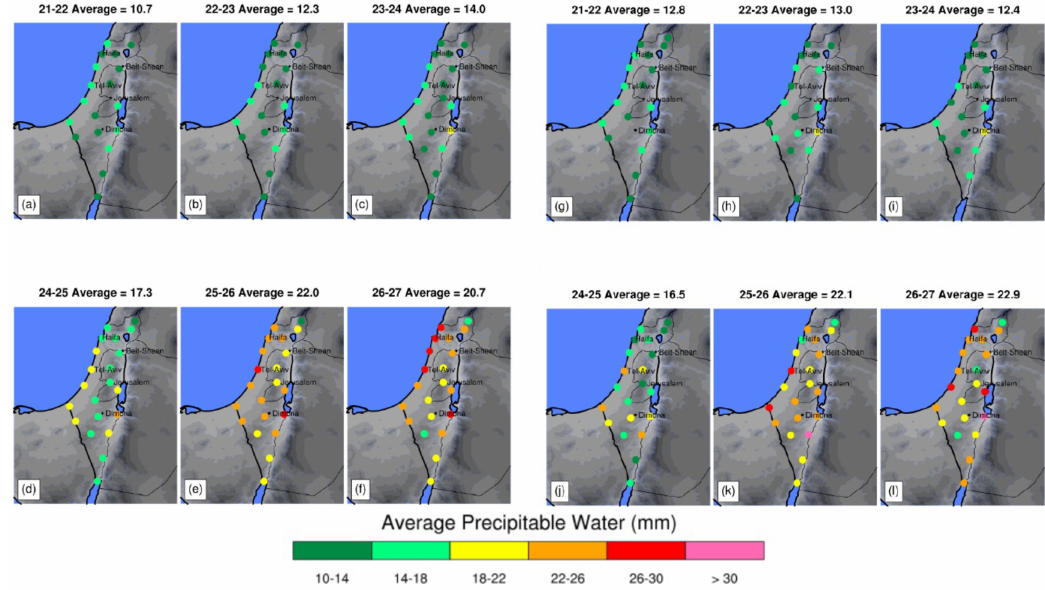
Figure 10. Average daily precipitable water derived from WRF Control simulation ( a – f ) and S-2.0 ( g – l ) output from hourly output for the days shown. Average values are shown in the